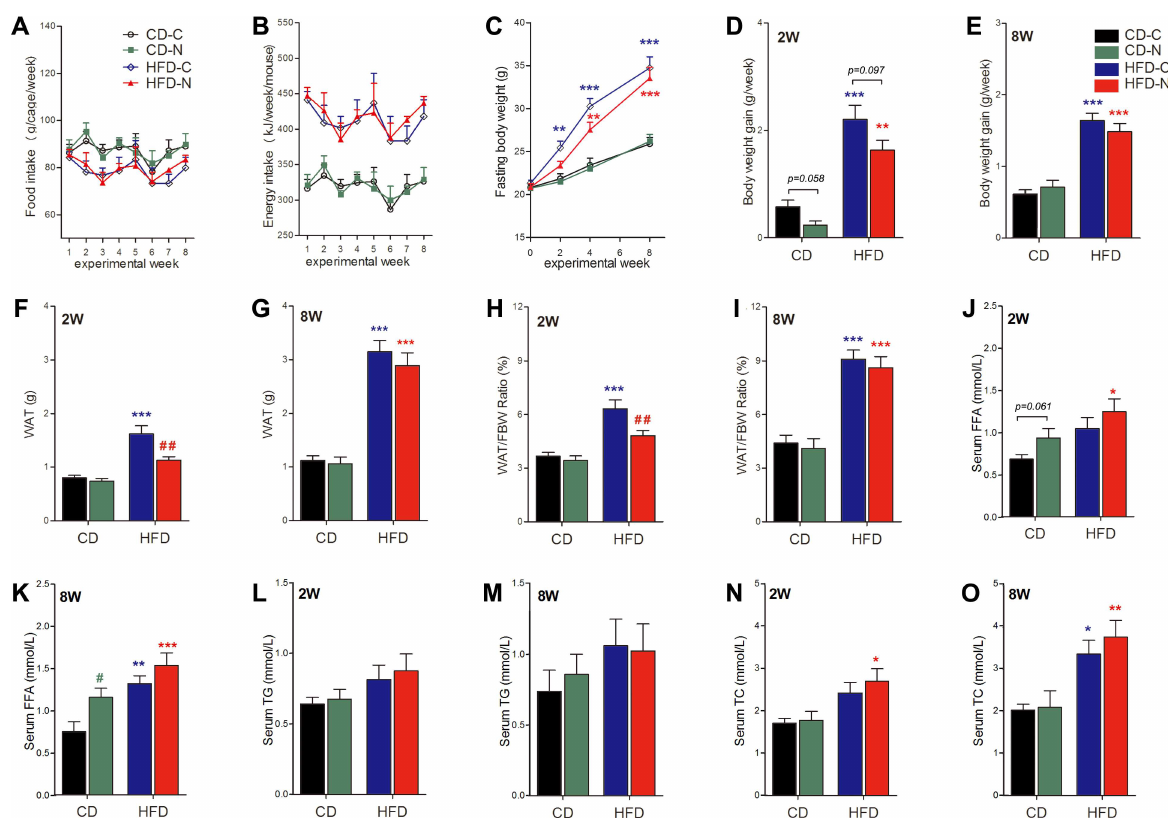
Fig 4. Effect of noise exposure on body composition and blood lipid profiles. (A) Food intake was measured on a per-cage basis once per week. The values are presented as the means ± SEM of 4 cages per group in first 2 weeks and 2 cages per group in following 6 weeks. (B) Energy intake calculated based on average weekly food consumption per mouse and dietary energy density. The values are presented as the means ± SEM of calculated energy intake per mouse from each cage. (C) The bodyweight of 16-hour fasted mouse was taken as fasting bodyweight (FBW). Values are presented as the means ± SEM of 16 (measured at experimental week 0, before the treatment) or 8 (measured before the IPGTT after 2, 4, and 8 weeks of treatment) mice per group. (D-E) Bodyweight gain of each group in the first 2 weeks (D) and throughout the 8-week treatment (E). (F-G) White adipose tissue (WAT) weight of each group after 2 weeks (F) and 8 weeks (G) of treatment. (H-I) The ratio of WAT over bodyweight after 2 weeks (H) and 8 weeks (I) of treatment. (J-K) Serum FFA concentrations of each group after 2 weeks (J) and 8 weeks of treatment (K). (L-M) Serum TG. (N-O) Serum TC. Values are presented as the means ± SEM of 8 mice per group. (cid:3) p < 0.05, (cid:3)(cid:3) p < 0.01 and (cid:3)(cid:3)(cid:3) p < 0.001 indicate the significance in the Tukey’s post hoc comparison between each group and the CD-C after a one-way ANOVA. # p < 0.05 and ## p < 0.01 indicate the significant difference between the noise group and diet-matched control group (CD-N vs CD-C and HFD-N vs HFD-C) determined using Bonferroni’s post hoc test following a two-way ANOVA with the factors of diet and noise.